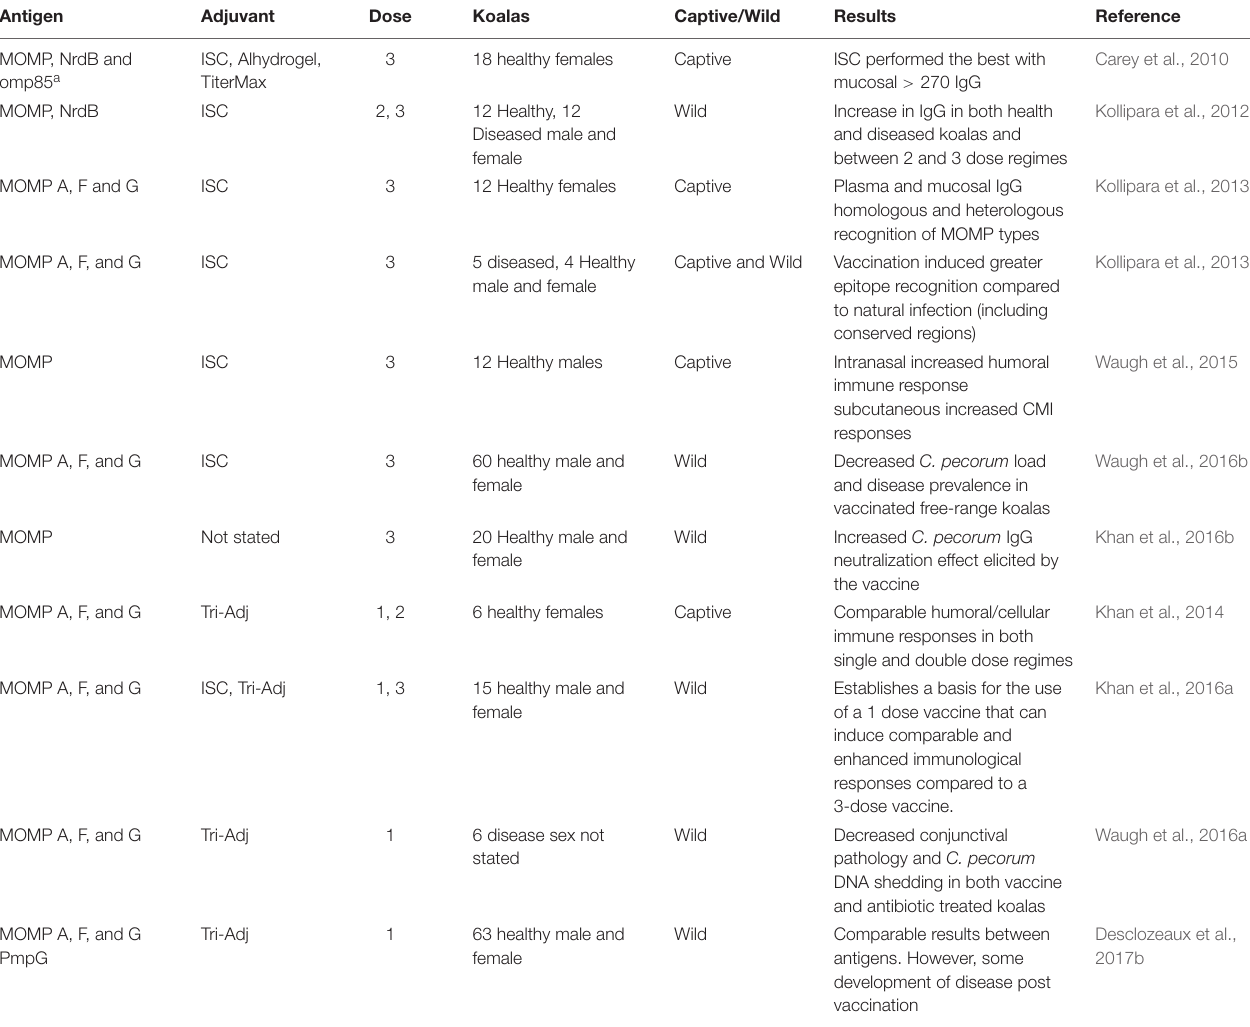
TABLE 6 | Chlamydia vaccine trials in